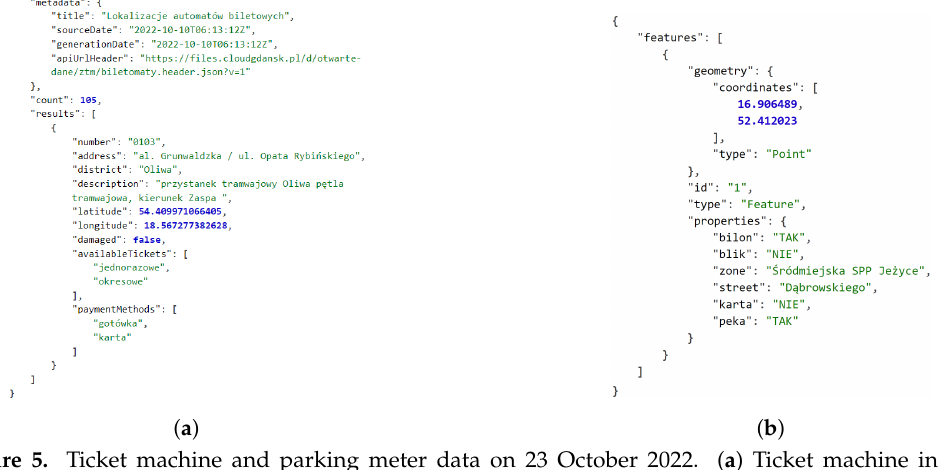
Figure 5. Ticket machine and parking meter data on 23 October 2022. ( a ) Ticket machine in Gda´nsk [91]. ( b ) Parking meter in Pozna´n